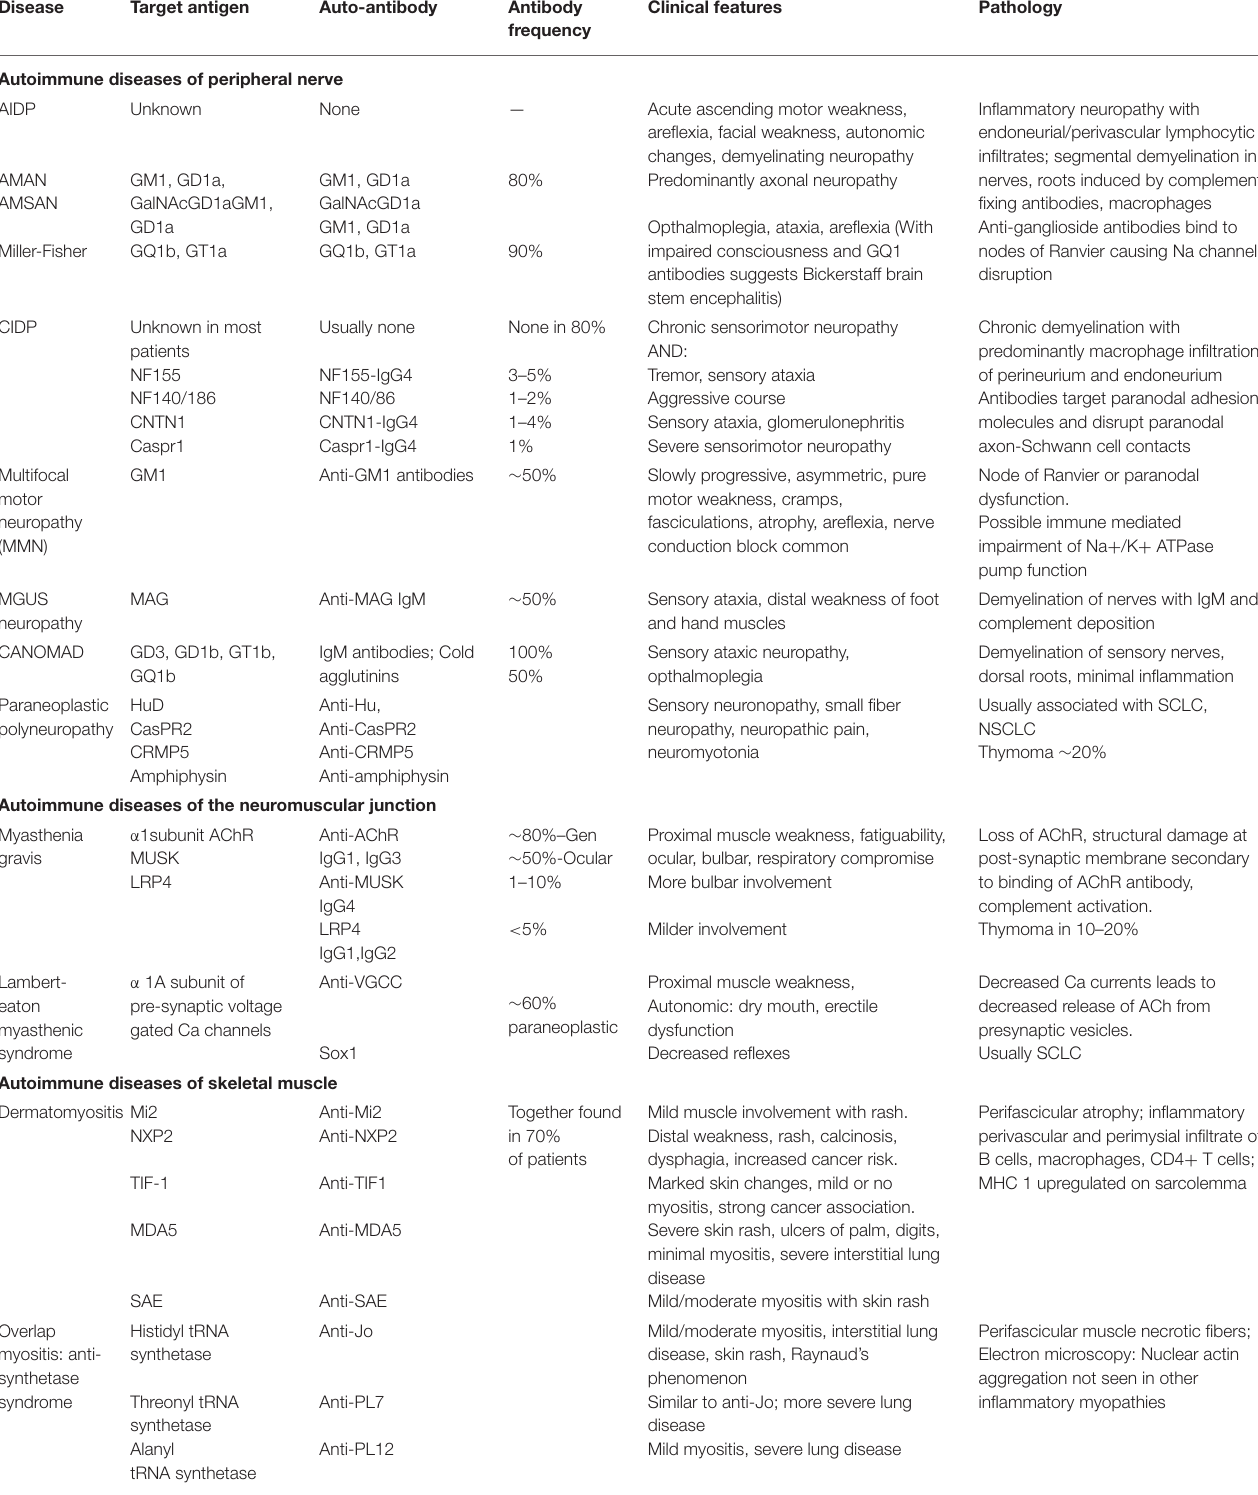
TABLE 3 | Autoimmune diseases of the peripheral nervous system.